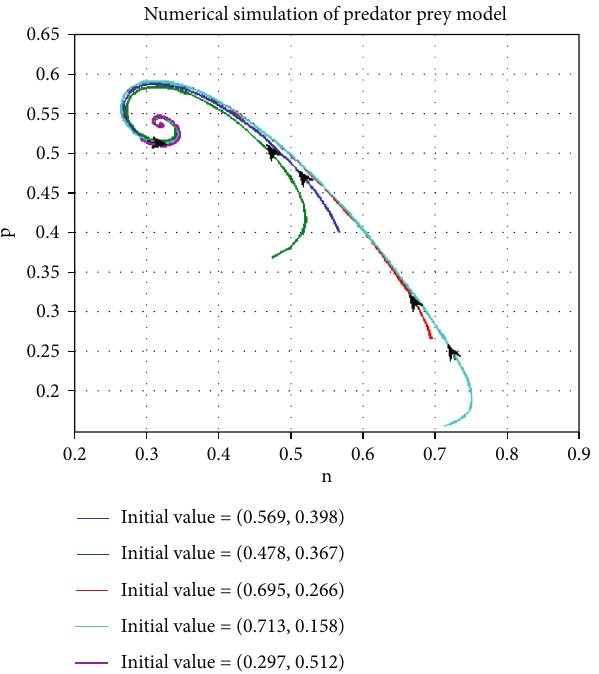
Figure 15: Phase plan trajectory of system (4) corresponding to di ff erent initial conditions I 1 = ð 0 : 569,0 : 398 Þ , I 2 = ð 0 : 478,0 : 367 Þ , I 3 = ð 0 : 695,0 : 266 Þ , I = ð 0 : 713,0 : 158 Þ , and I = ð 0 : 297,0 : 512 Þ . 4 5